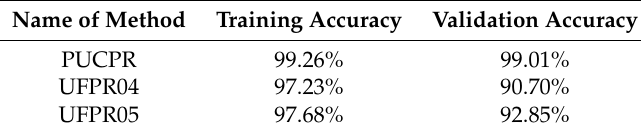
Table 2. Comparisons of training and validation accuracies for subsets of PKLot dataset